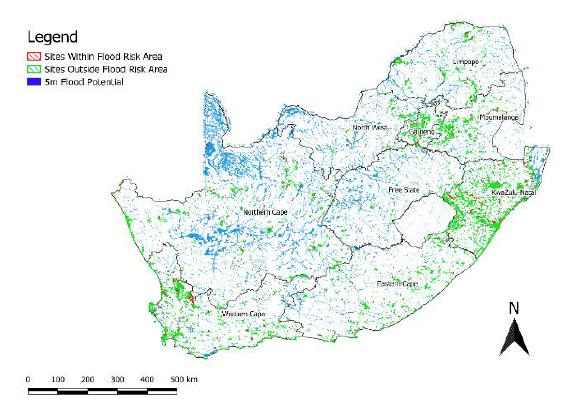
Figure 5: 5 Meter flood risk analysis (SAHRA, 2019) Based on the 5 meter flood projection, 11.78% of all generally and formally protected resources are at risk of being impacted by flood from river channels (SAHRA, 2019).